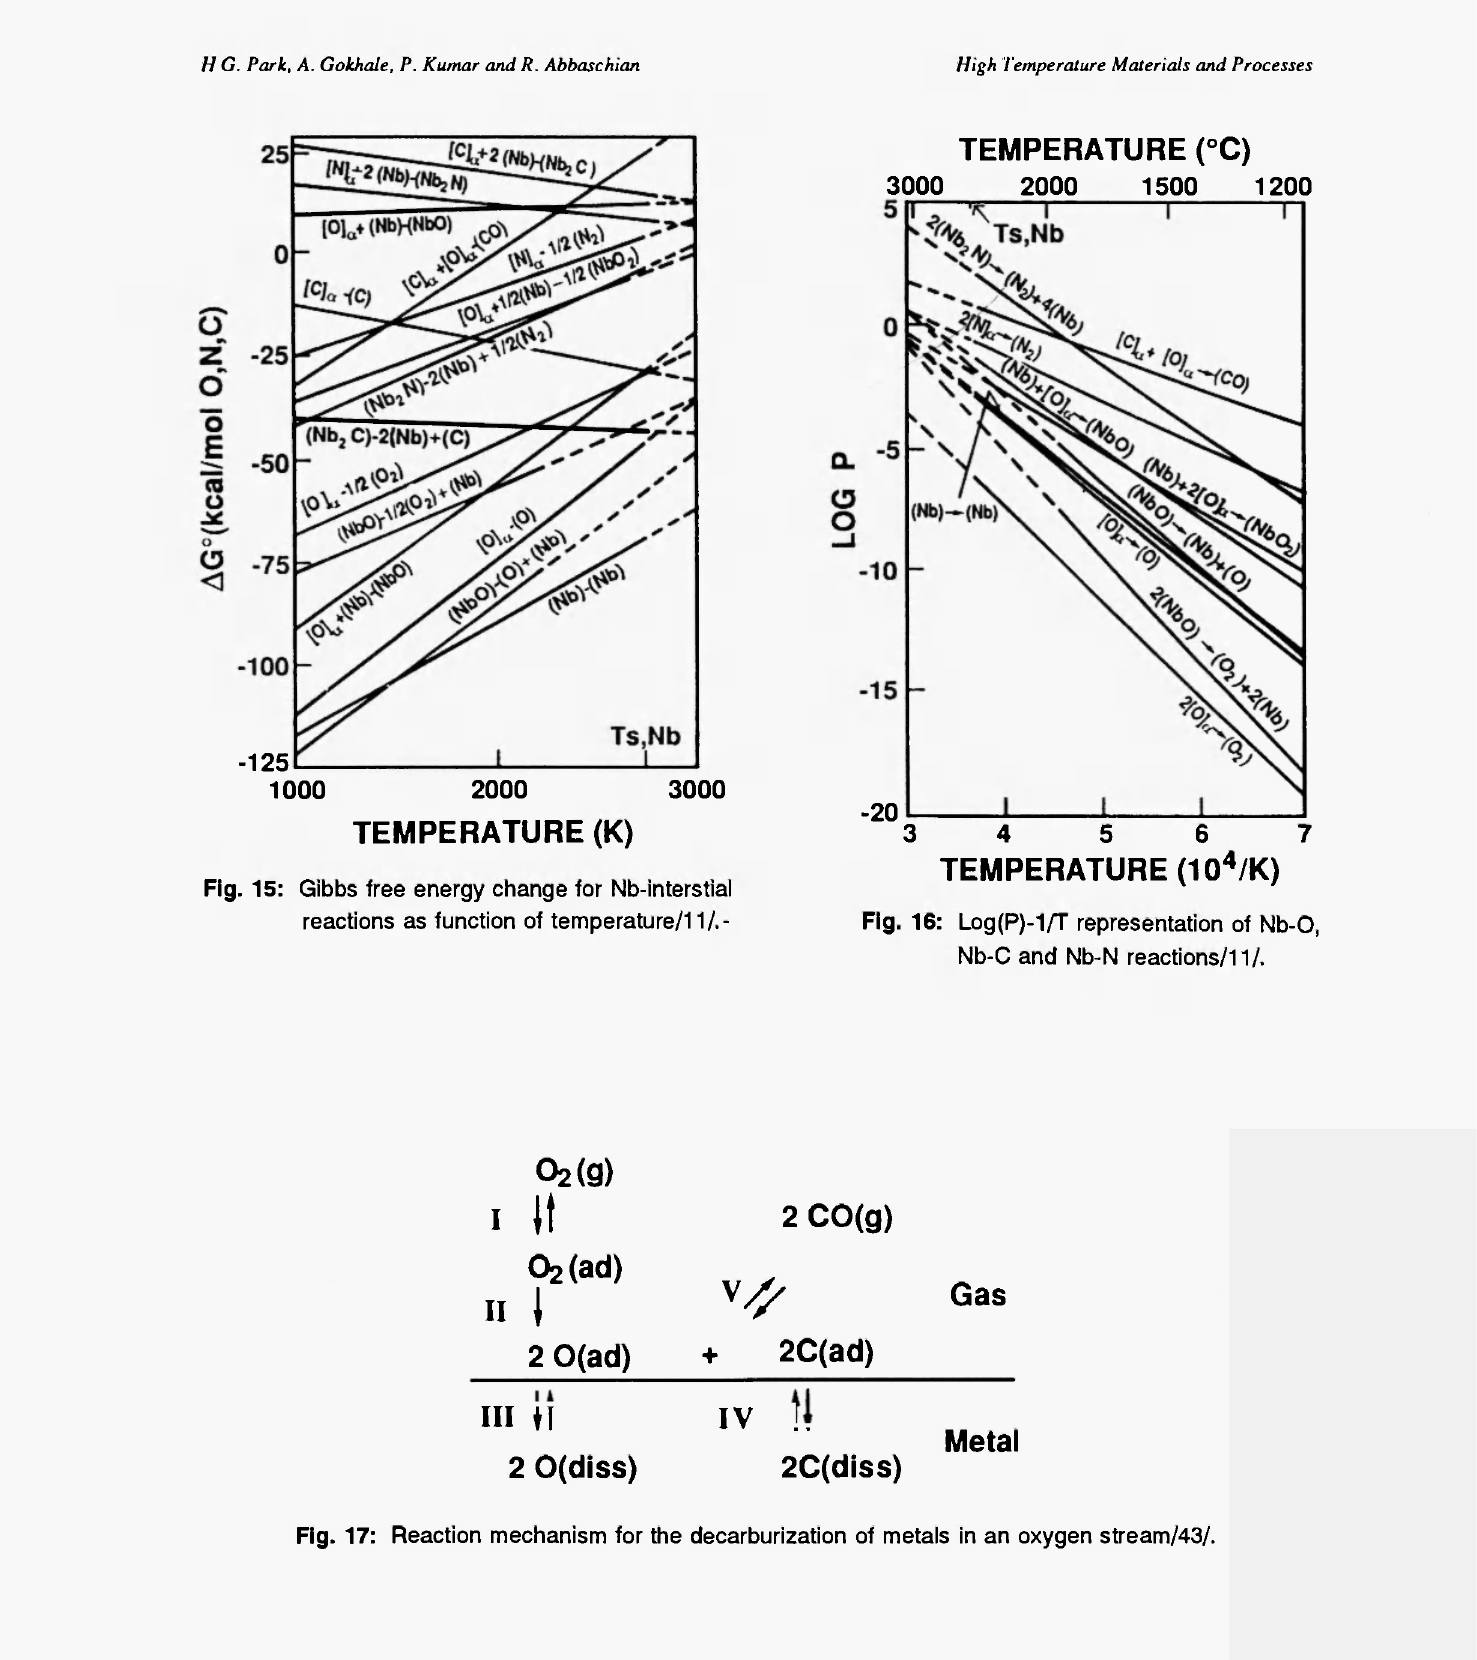
Fig. 17: Reaction mechanism for the decarburization of metals in an oxygen